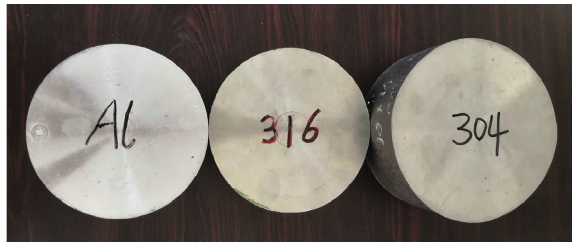
Figure 5: Metal bases used in the